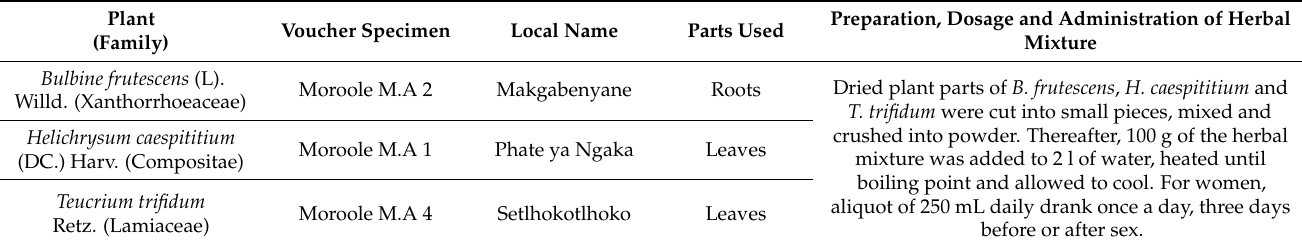
Table 1. Herbal mixture used for contraception by the Batswana traditional health practitioners in Ngaka Modiri Molema District Municipality, South